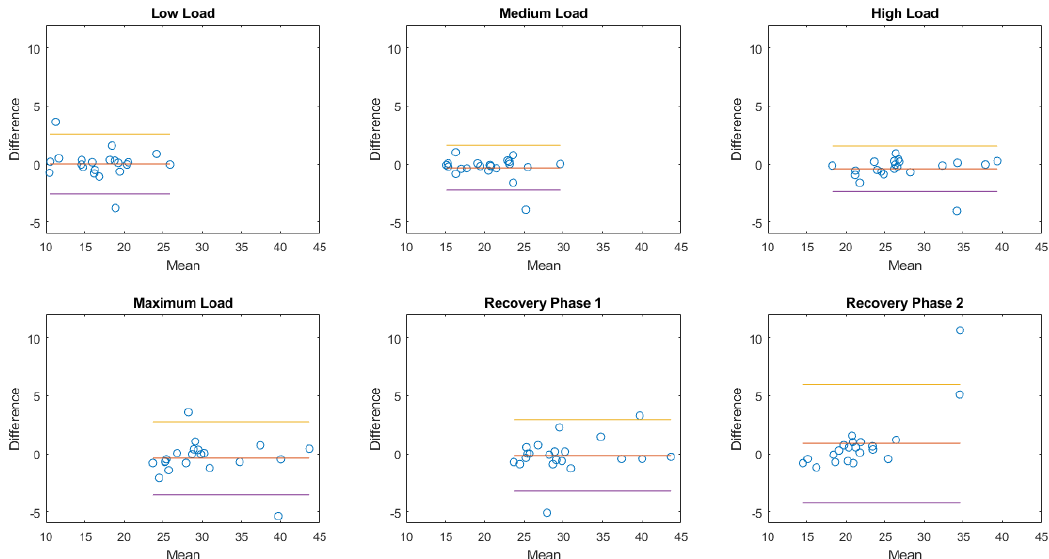
Figure 15. Bland–Altman plots of the aggregated results of normalized amplitude during exercise. Each dot represents the value obtained from a single subject. The yellow line represents the upper limit of agreement (mean error +1.96 × standard deviation); the red line represents the mean error; the purple line represents the lower limit of agreement (mean error −1.96 × standard deviation).